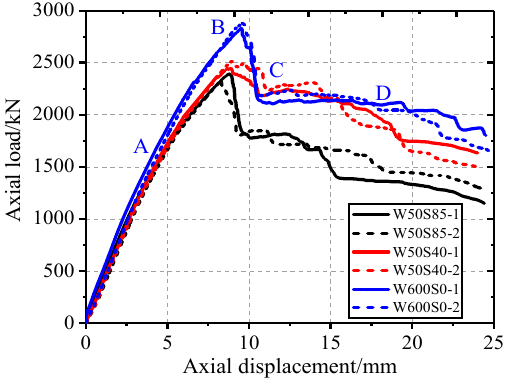
Figure 5. Axial load–displacement curve.